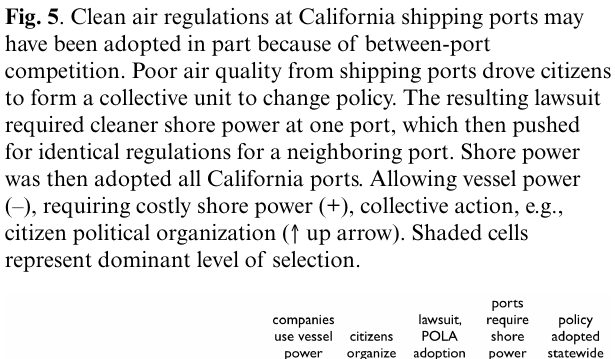
Fig. 5 . Clean air regulations at California shipping ports